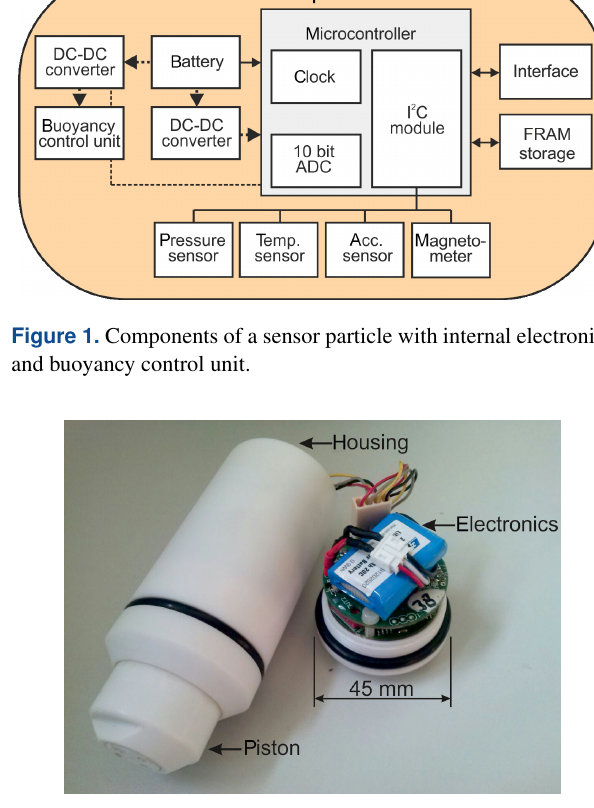
Figure 2. Open sensor particle with the electronics and the ex- tended piston of the buoyancy control